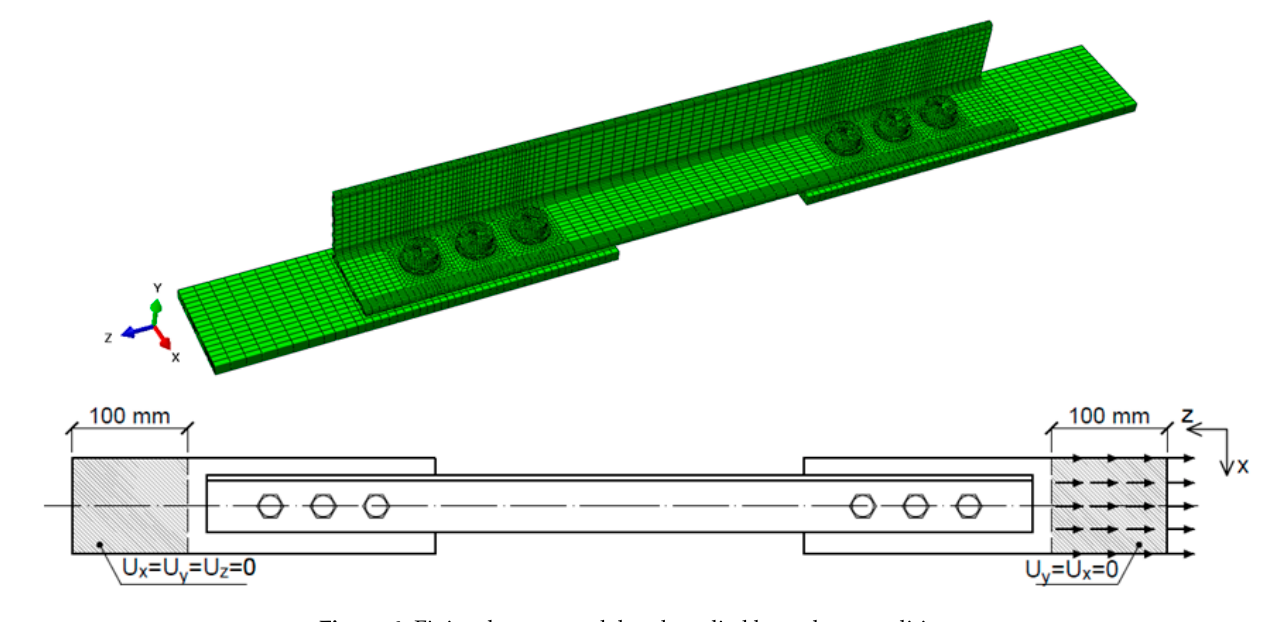
Figure 6. Finite element model and applied boundary conditions.